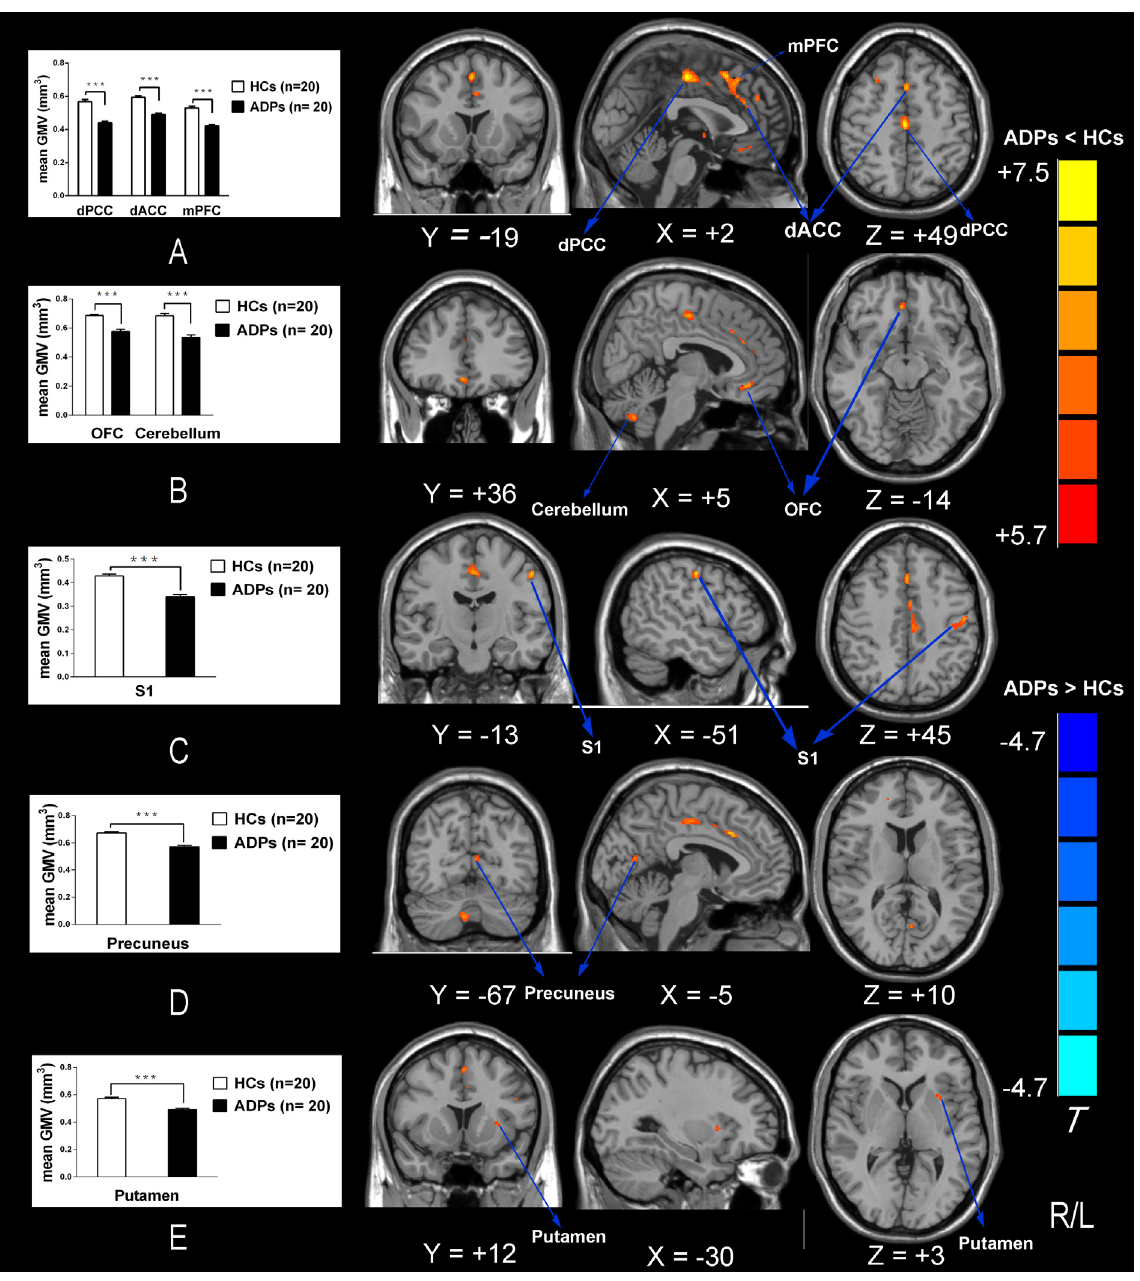
Fig 2. Whole-brain GMV was compared between ADPs and HCs using SPM8 plus DAREL analysis. VBM differences reflect GMV decreased in ADPs including the bilateral dACC, the left dPCC, the left mPFC, the right premotor cortex, the left S1, the right OFC, the left precuneus, the left putamen and the right cerebellum. (A-E) GMV was also extracted from the regions that revealed significantly lower GMV in ADPs shown in the Fig Abbreviations: dACC, dorsal anterior cingulate cortex; dPCC, dorsal posterior cingulate cortex; mPFC, medial prefrontal cortex; S1, primary somatic sensory cortex; OFC, orbitofrontal cortex; GMV, grey matter volume; ADPs, alcohol dependent patients; HCs, healthy